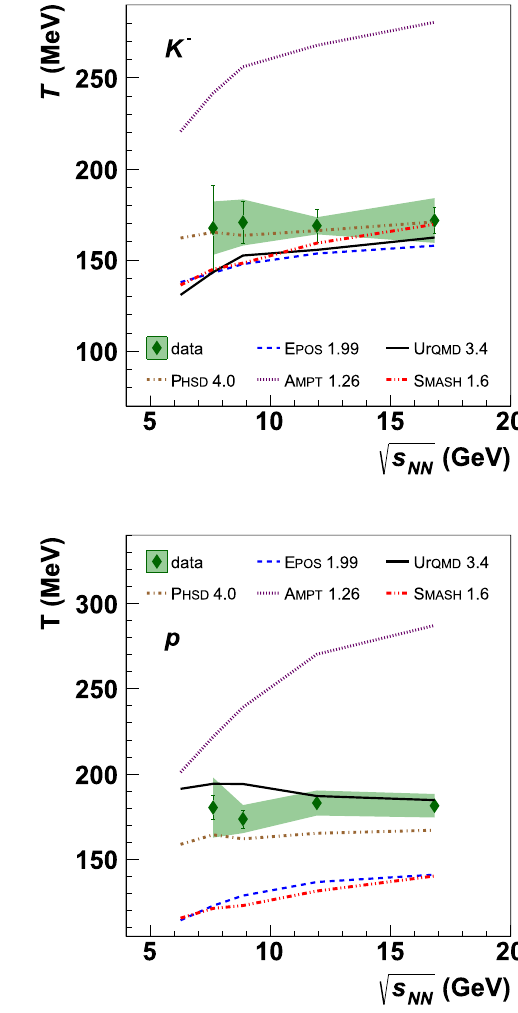
collisions with models: Epos 1.99 (blue dashed line), U r qmd 3.4 (black solid line), Ampt 1.26 (violet dotted line), Phsd 4.0 (brown dashed- dotted line) and Smash 1.6 (red dashed-double dotted